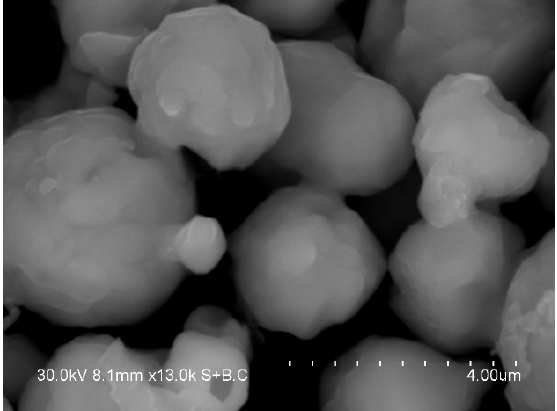
Figure 9. Mössbauer spectrum of the product of acid treatment of Fe@Pd core–shell particles (hollow particles): dots—experimental data, black line—spectrum (singlet).